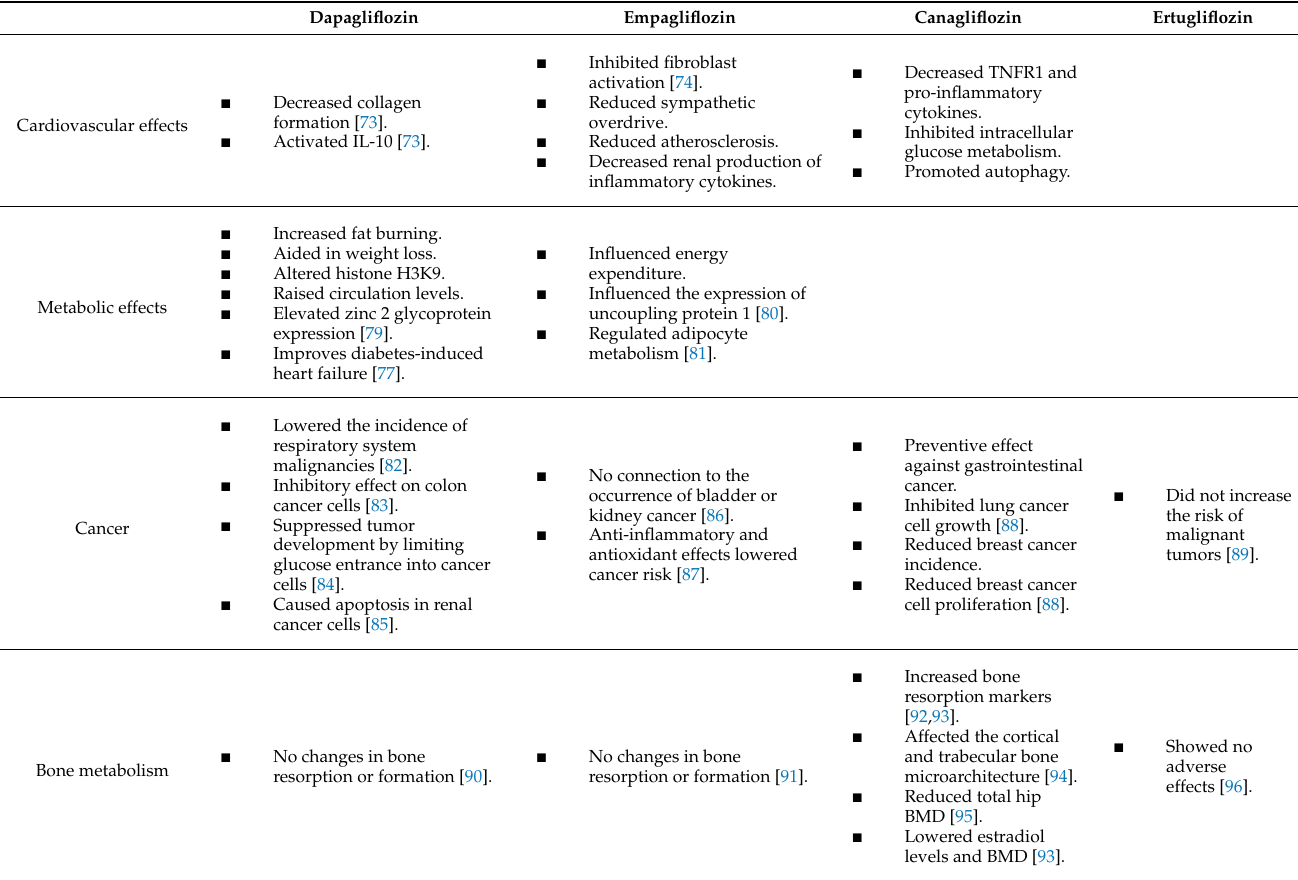
Table 2. Actions of SGLT2 inhibitors on different body systems. Dapagliflozin Empagliflozin Canagliflozin